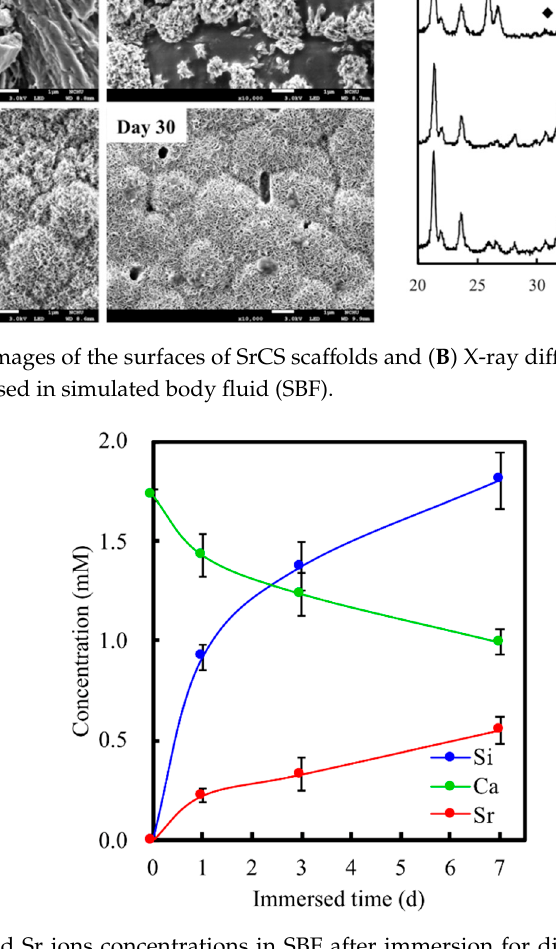
Figure 3. Ca, Si, and Sr ions concentrations in SBF after immersion for different durations. Data presented as mean ± SEM, n = 6 for each group.